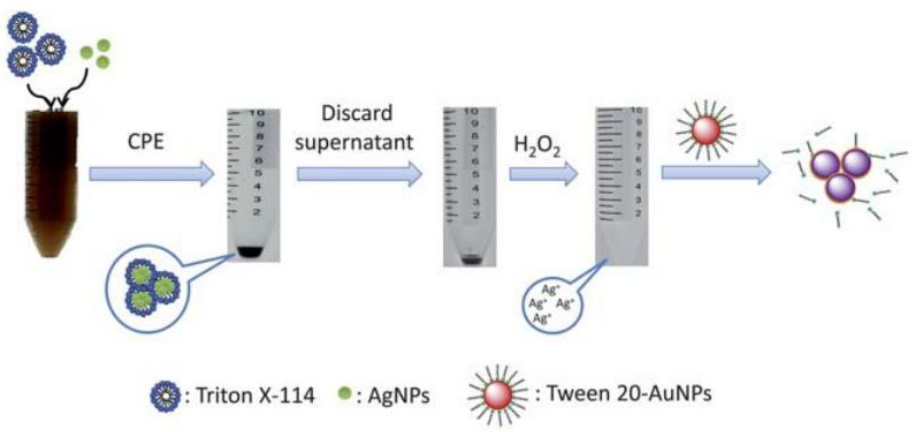
Figure 9. Separation of AgNPs by Triton X-114-based CPE. Reproduced from Ref. [63] with permis- Figure 9 sion from the Royal Society of